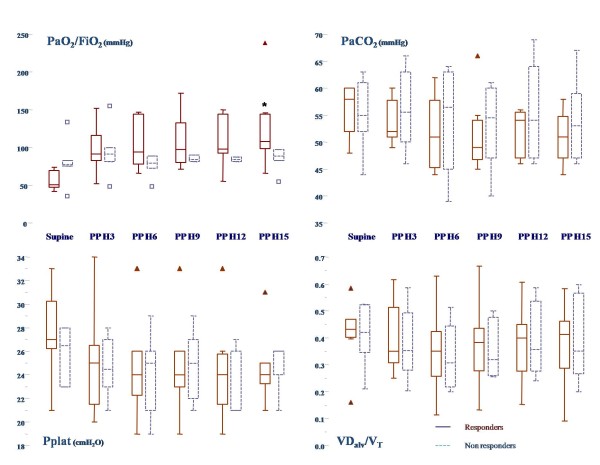
Alterations during PP in PaO2/FiO2, PaCO2, plateau pressure (Pplat) and alveolar dead space (VDalv/VT) in responders (solid lines) and nonresponders (dotted lines) according to PaO2/FiO2 changes. "PaO2 responders" were defined by an increase in PaO2/FiO2 > 20 mmHg after 15 hours of PP (PP H15). Shown are box and whisker plots. Median = horizontal line inside the box; upper and lower quartiles = whisker plot. Boxes and triangles represent values higher or lower than the upper or lower quartiles. *P < 0.05 for comparison of changes in responders versus nonresponders. PP: prone position.